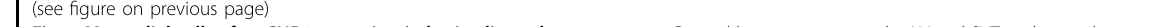
Fig. 7 More glial cells after CHD8 targeting in brain slice culture system. a Cortical brain region near the LV and SVZ in the newborn monkeys was isolated for brain slice culture. OB olfactory bulb, Hippo hippocampus, Cere cerebellum. b After infection with lentivirus for 10 days, the brain slices showed strong GFP signaling, re fl ecting lentiviral transduction. Scale bar: 100 μ m. c Immunostaining of the infected brain slices showing that GFP-positive cells contain NeuN positive and negative cells. Scale bar: 25 μ m. d Double immunostaining showing that lentiviral CHD8 gRNA/Cas9 expression, re fl ected by GFP expression, reduced CHD8 expression and occurred in astrocytes and oligodendrocytes. Scale bar: 10 μ m. e Double immunostaining of the brain slice region near the LV showing that the density of olig2-labeled oligodendrocytes and SOX9-labeled astrocytes was increased in the lentiviral CHD8 gRNA/Cas9 infected region as compared with lentiviral control gRNA/Cas9 infection. Scale bar: 25 μ m. f Quantitation of the relative numbers of oligodendrocytes and astrocytes. Nine brain slices from three newborn monkeys were used for statistical analysis. The data are presented as means ± SEM. ** P < 0.01; *** P <